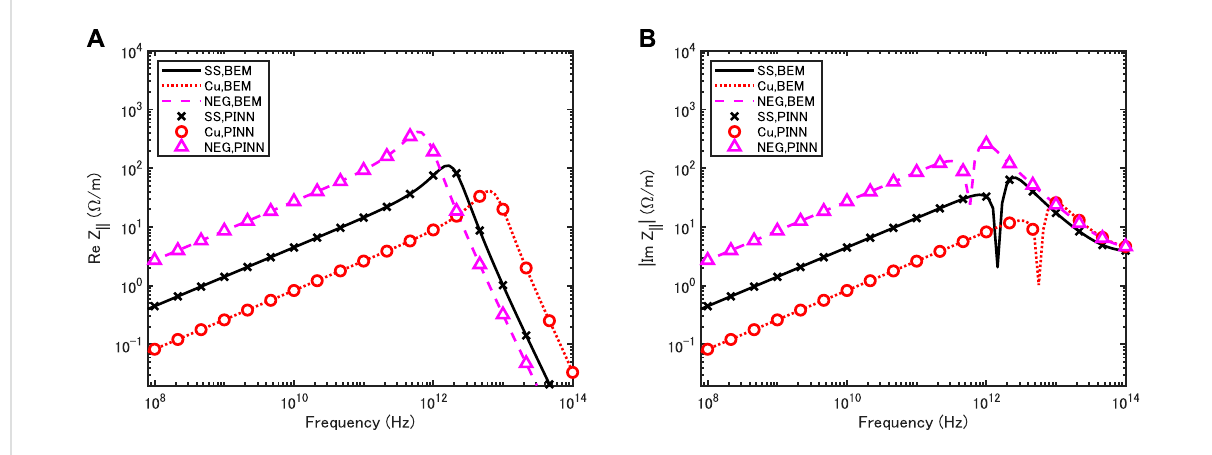
FIGURE 5 Coupling impedances of a round Gaussian beam with σ r = 0.5 mm moving on the axis of a circular vacuum chamber with in fi nite thickness for three different wall materials: copper (Cu), stainless steel (SS), nonevaporable getter (NEG). The copper and NEG chambers have radius of 5 mm and the SS chamber has radius of 6 mm. Real part (A) and imaginary part (B) .